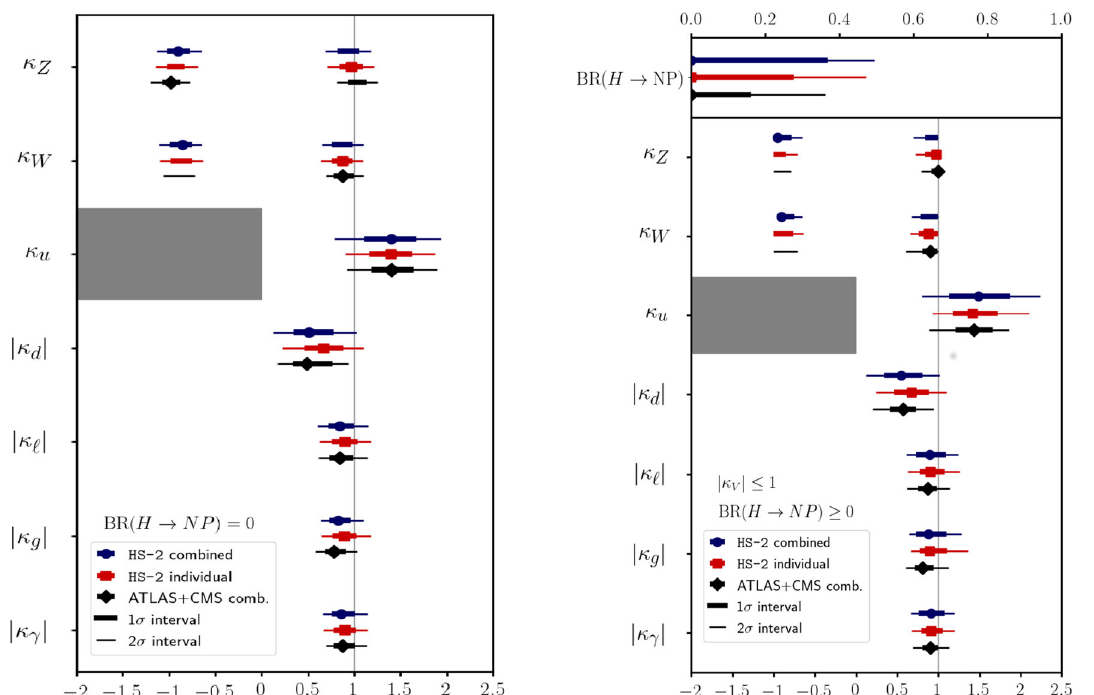
Fig. 6 Official and reproduced ATLAS and CMS combined Run-1 results in the Higgs coupling scale factor parametrization, assuming no new BSM Higgs decay modes (left panel) or κ V ≤ 1 (right panel). The HiggsSignals-2 results have been obtained using as input either the combined measurements (blue) or measurements from individual